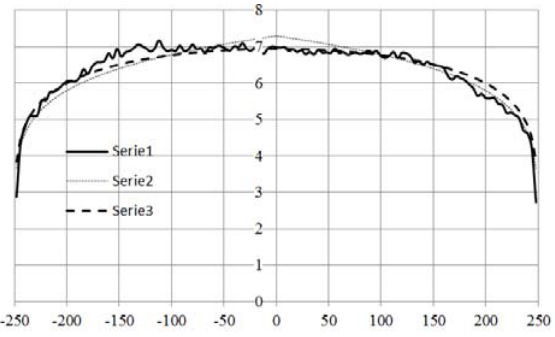
Fig. 5 . Velocity distribution along the axis w